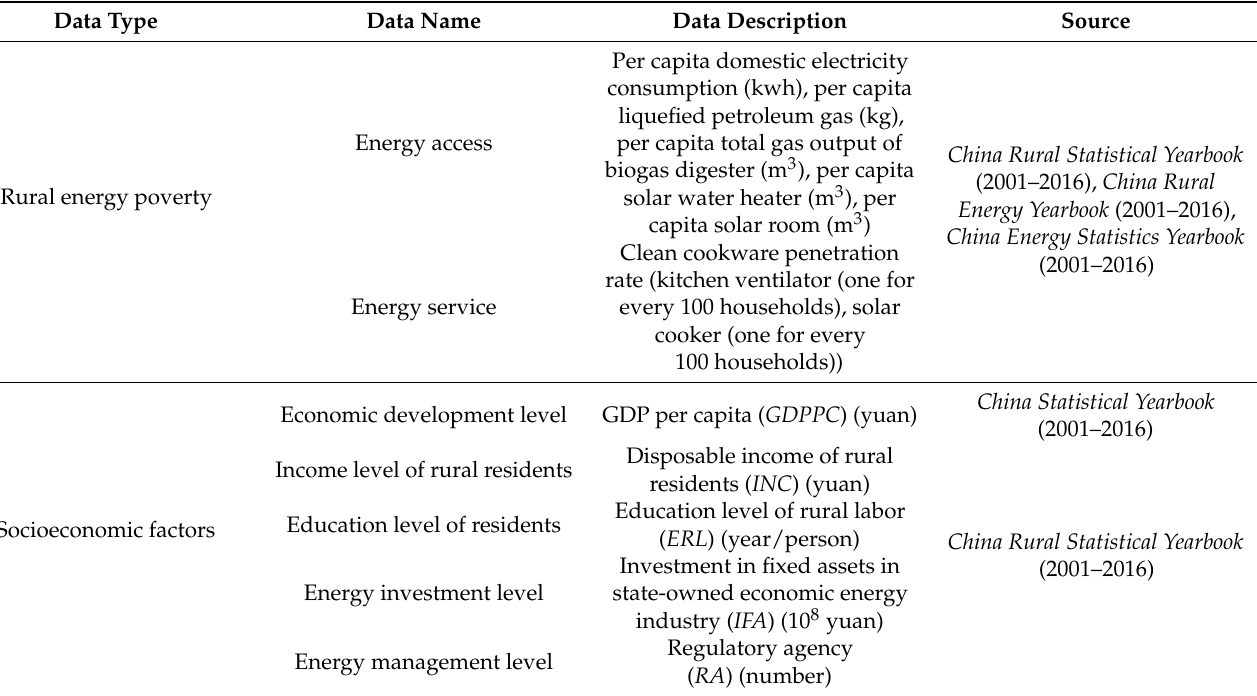
Table 1. Details of data used in this